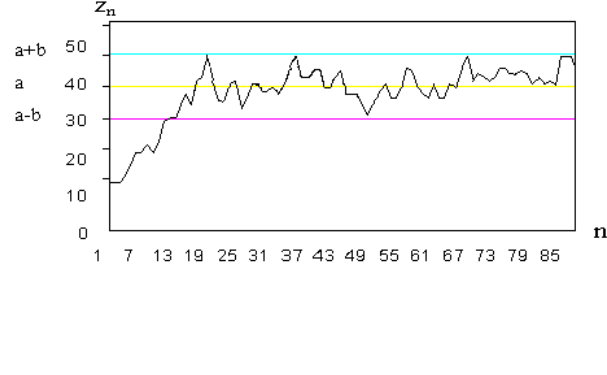
Figure 1. SDS cluster stabilisation. ( a ) The threshold level; ( b ) the amount of tolerance; the x-axis describes the number of iterations, n , while the y-axis describes the percentage of active agents.